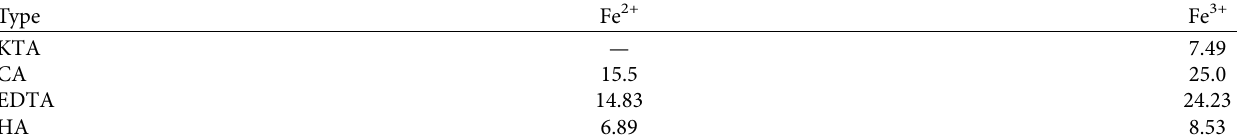
Table 3: Complex stability constants of Fe 2+ /Fe 3+ with various carboxylic acids.